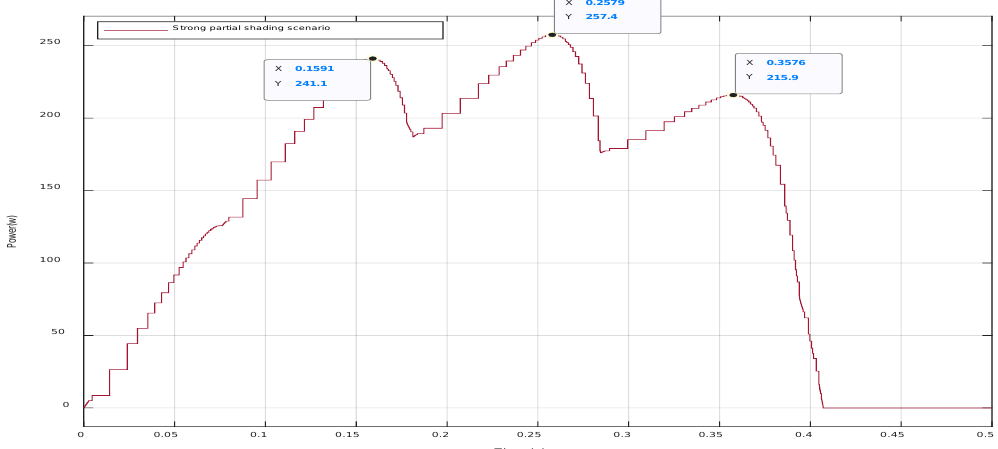
Figure 11. Scenario of Case Three (Strong shading pattern).